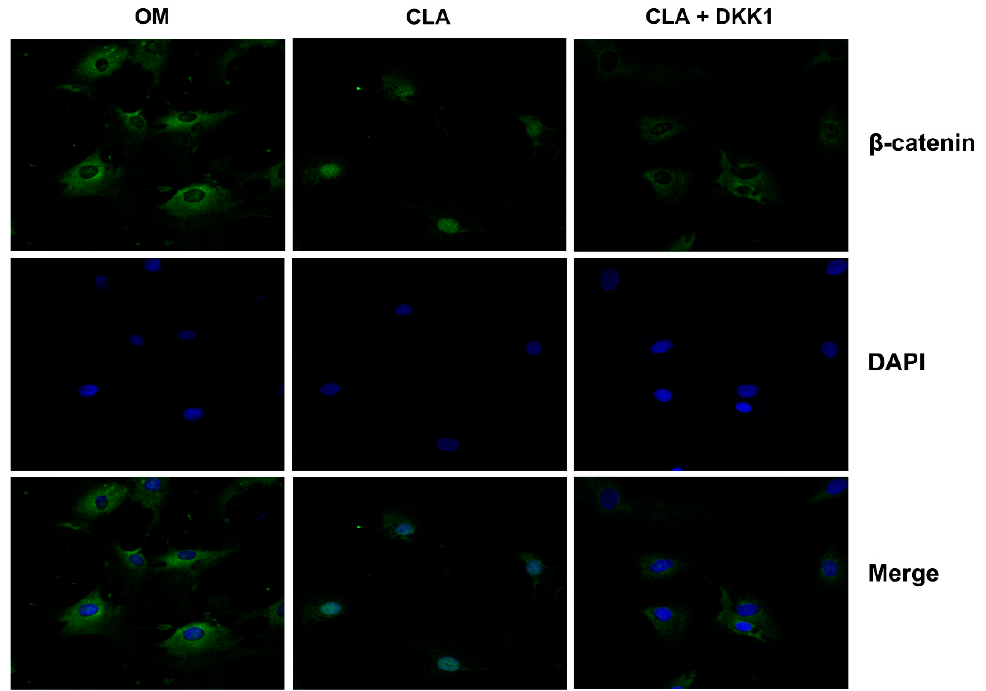
Figure 8. DKK1 inhibited CLA-stimulated nuclear translocation of β -catenin (100×). hBMSCs (Con) were induced for osteogenic differentiation for 48 h (OM), with 1 μ M CLA alone (CLA), or 1 μ M CLA (Con) were induced for osteogenic differentiation for 48 h (OM), with 1 µ M CLA alone (CLA), and 0.5 μ g/mL DKK1 (CLA + DKK1). Expression of β -catenin (green) was detected by or 1 µ M CLA and 0.5 µ g/mL DKK1 (CLA + DKK1). Expression of β -catenin (green) was detected by immunofluorescence staining, with nuclei stained using DAPI (blue). immunofluorescence staining, with nuclei stained using DAPI